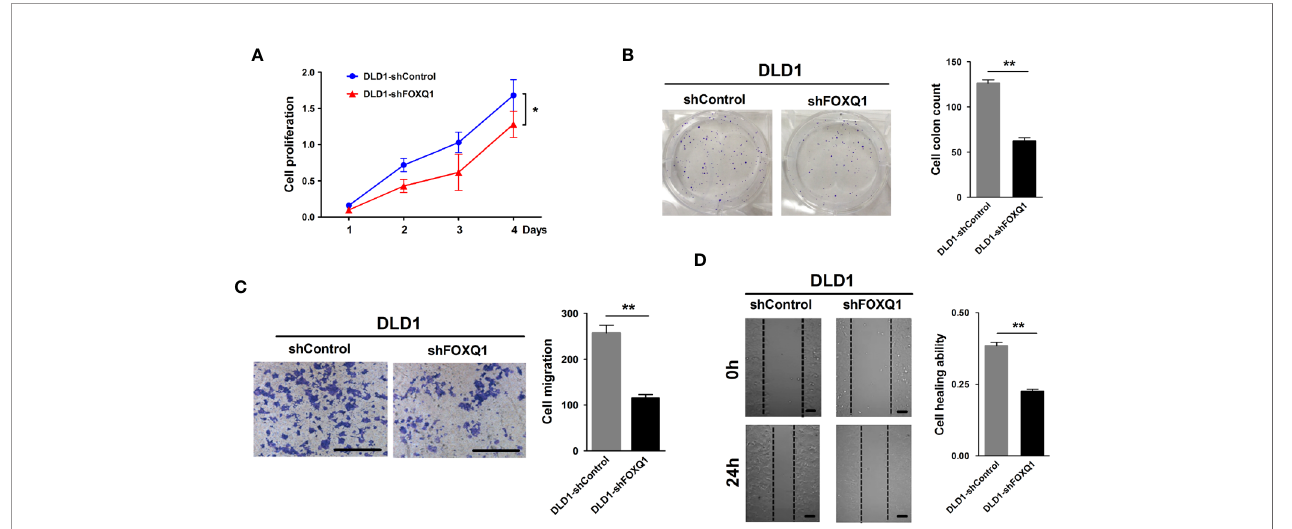
FIGURE 2 | Inhibition of FOXQ1 induces suppressed proliferation and migration of colorectal cancer (CRC) cells in vitro. (A) FOXQ1 inhibition signi fi cantly supressed cell proliferation of DLD1-shFOXQ1 compared with control. (B) Signi fi cant decrease of clone formation in DLD1-shFOXQ1 compared with control. (C) Representative images of inhibition in migration DLD1-shFOXQ1 compared with control. (D) Representative images of inhibition in wound healing ability in DLD1-shFOXQ1 compared with control. All scale bars represent 100 m m. * P <0.05, ** P <0.01 signify a signi fi cant difference between the indicated groups (two-tailed, unpaired Student ’ s t -test). Bars represent mean ± S.E. of three independent